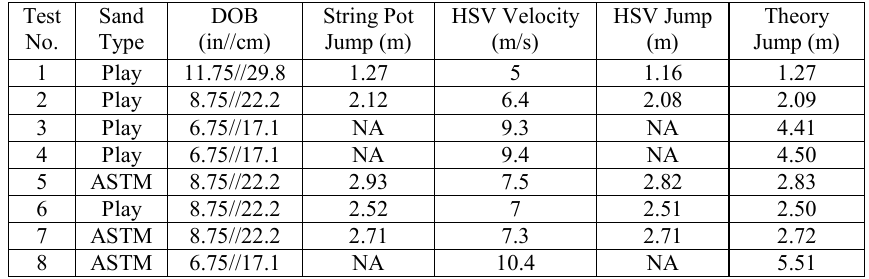
Table 1. Test Results